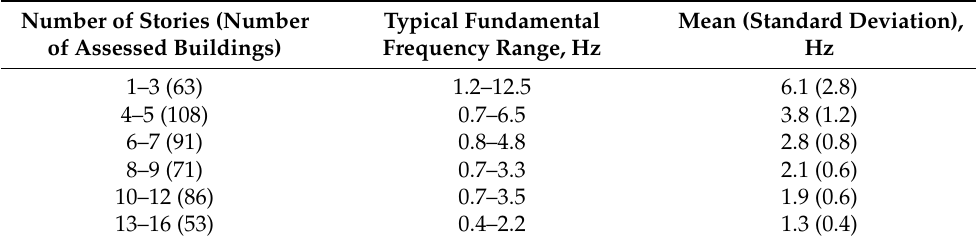
Table 1. Fundamental frequency ranges of buildings